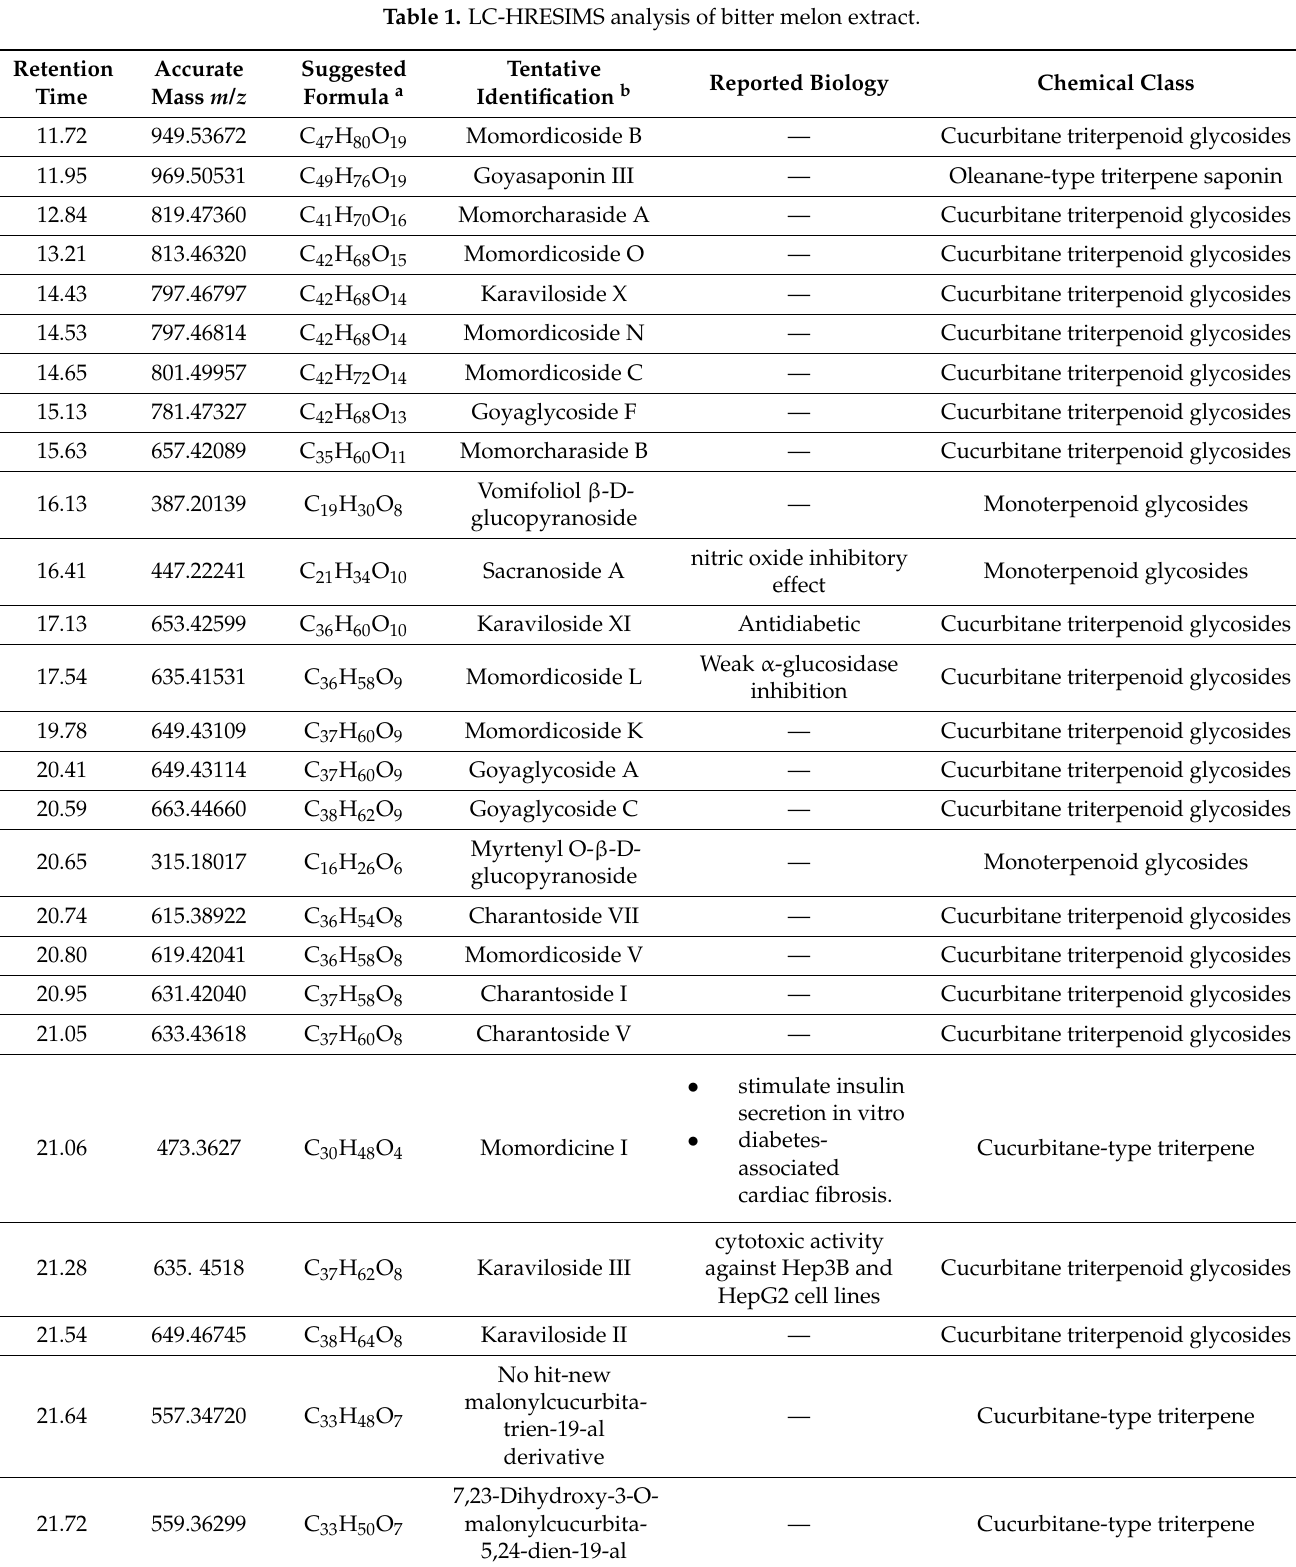
Table 1. LC-HRESIMS analysis of bitter melon